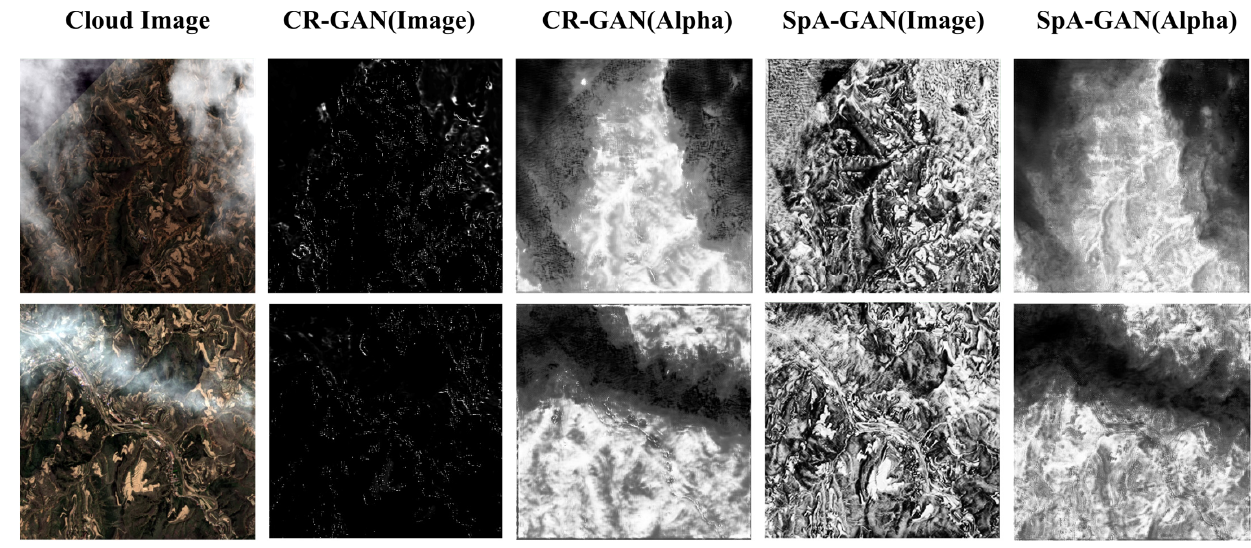
Figure A5. Visualization of the attention mechanism from CR-GAN and SpA-GAN networks under different conditions.